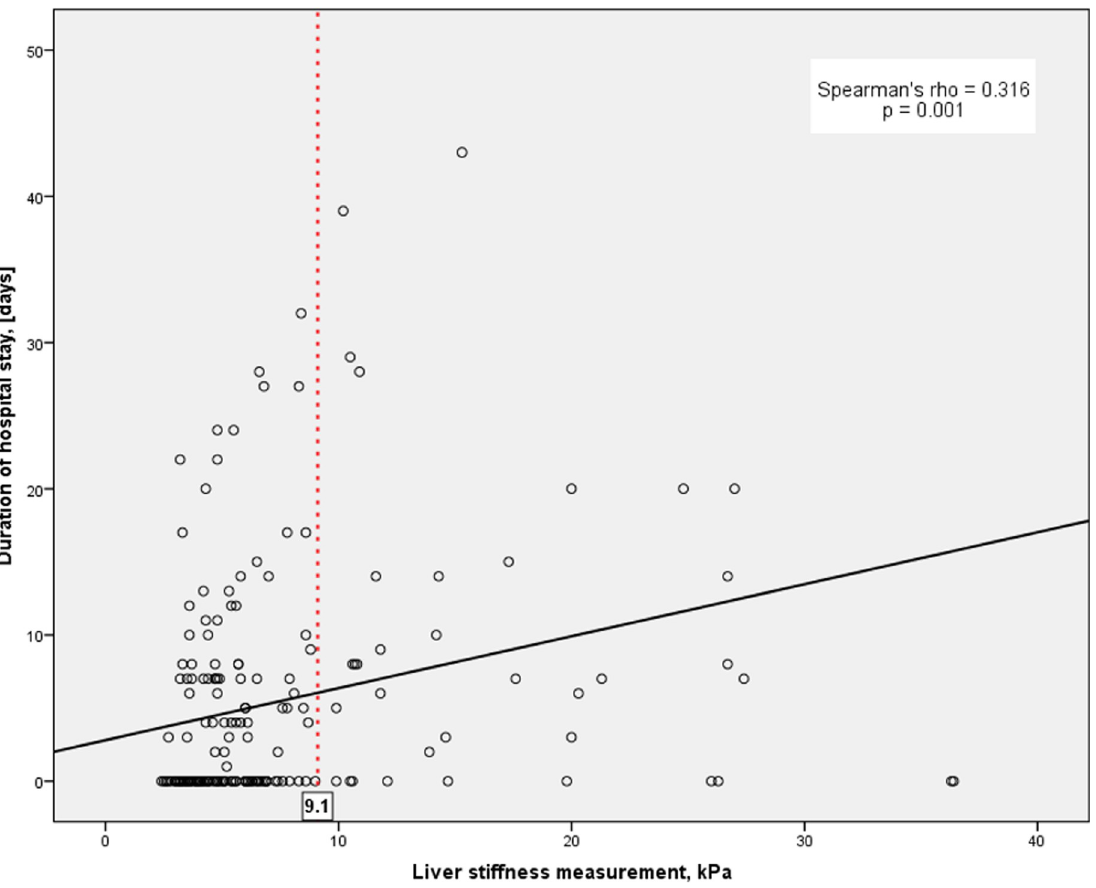
Fig 2. Duration of patient hospitalization in relation to LSM performed at